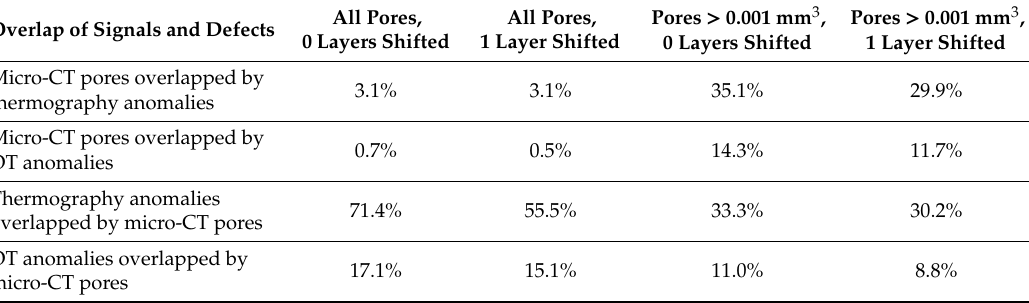
Table 5. Binary volumetric overlap of segmented pores from µ CT data and anomalies detected by thermography (TOT (700K) > 30 ms) and OT (OT signal > 700 DV), where the relative cumulative volumes compared with respect to cumulative pore volume are 90% for thermography and 8% for OT. All Pores, All Pores, Pores > 0.001 mm 3 , Pores > 0.001 mm 3 , Overlap of Signals and Defects 0 Layers Shifted 1 Layer Shifted 0 Layers Shifted 1 Layer Shifted Micro-CT pores overlapped by 3.1% 3.1% 35.1% 29.9% thermography anomalies Micro-CT pores overlapped by 0.7% 0.5% 14.3% 11.7% OT anomalies Thermography anomalies 71.4% 55.5% overlapped by micro-CT pores OT anomalies overlapped by micro-CT